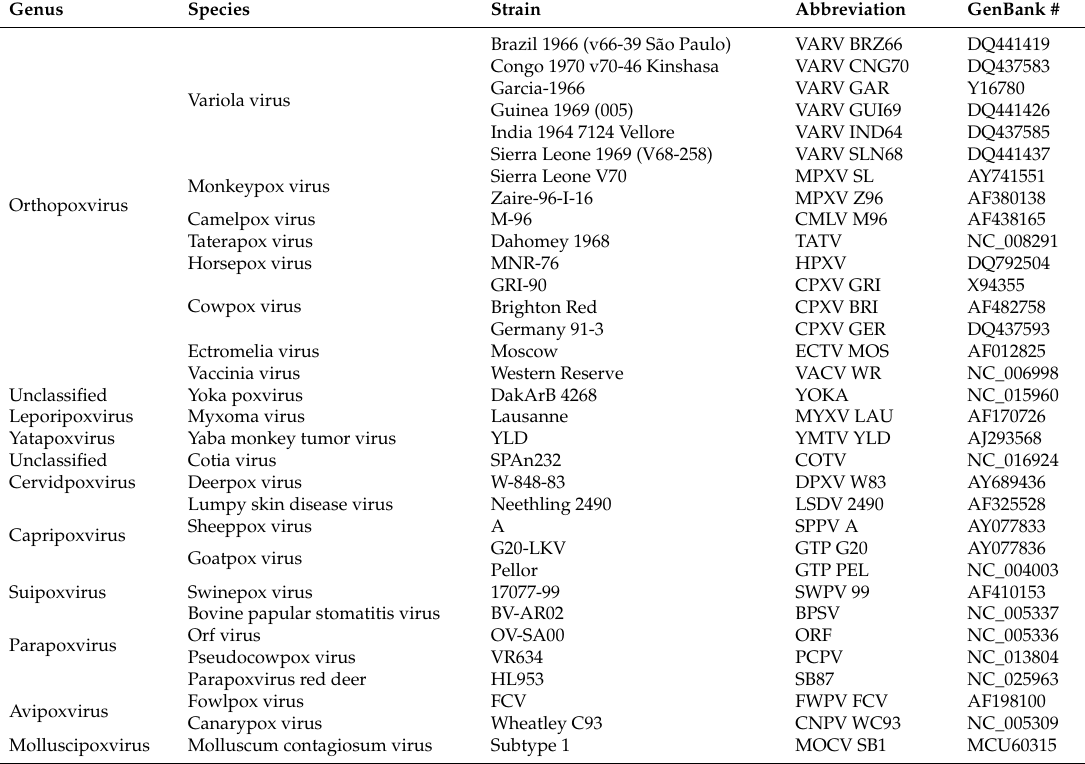
Table 1. Genomic sequences of the poxviruses used in this